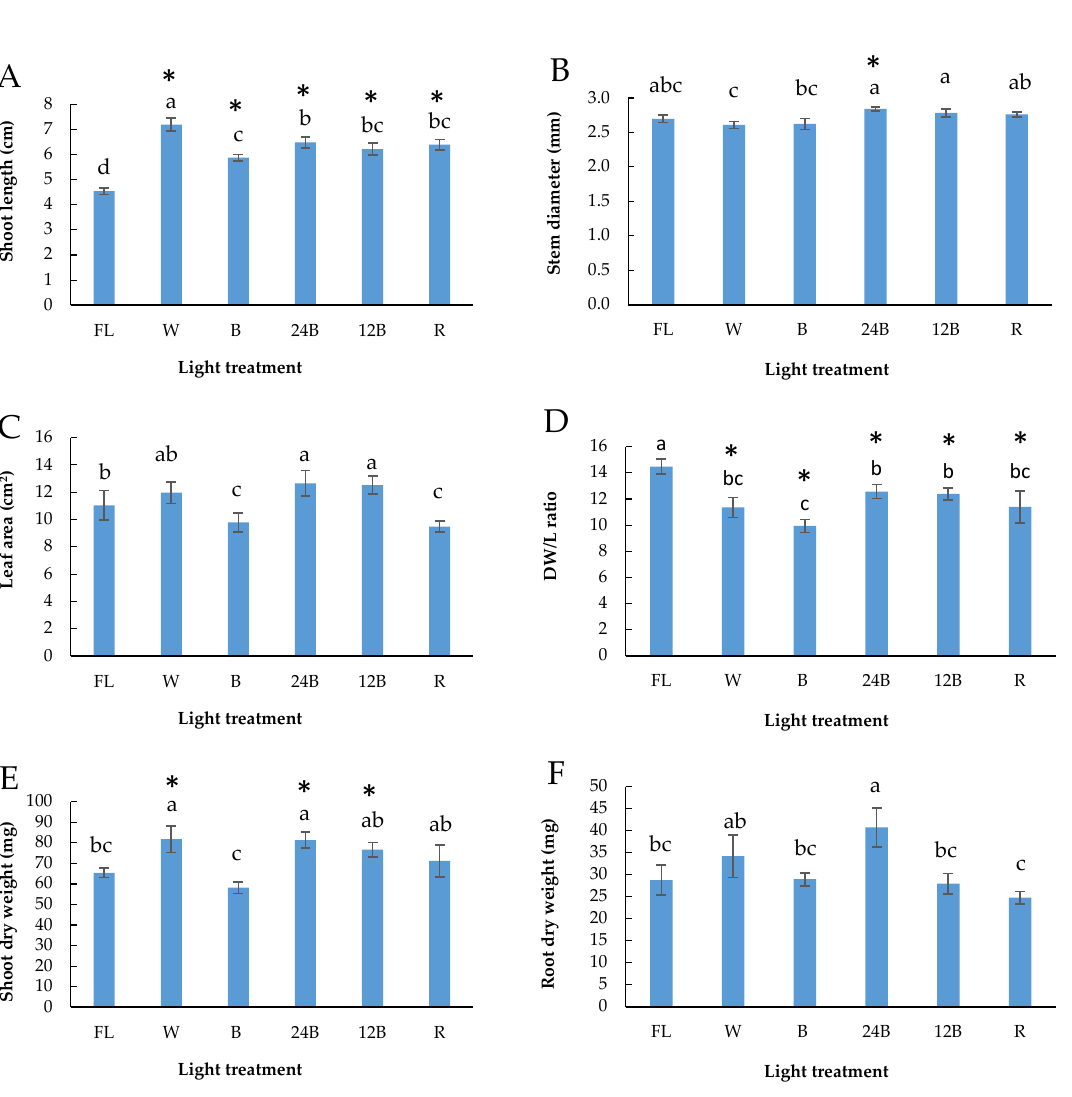
Figure 2. ( A ) Shoot length, ( B ) stem diameter, ( C ) leaf area, ( D ) dry weight/length (DW/L) ratio, ( E ) shoot dry weight and ( F ) root dry weight of 10 grafted tomato seedlings per light treatment after their exposure to six light treatments during healing. Bars ( ± SE) followed by different letters are significantly different ( p ≤ 0.05) according to the LSD method. Bars ( ± SE) followed by asterisks indicate significant differences between the LED treatments and the control (FL) at p ≤ 0.05 according to t -test. FL: fluorescent lamps; W: white; B: blue; 24B: 24% blue; 12B: 12% blue; R: